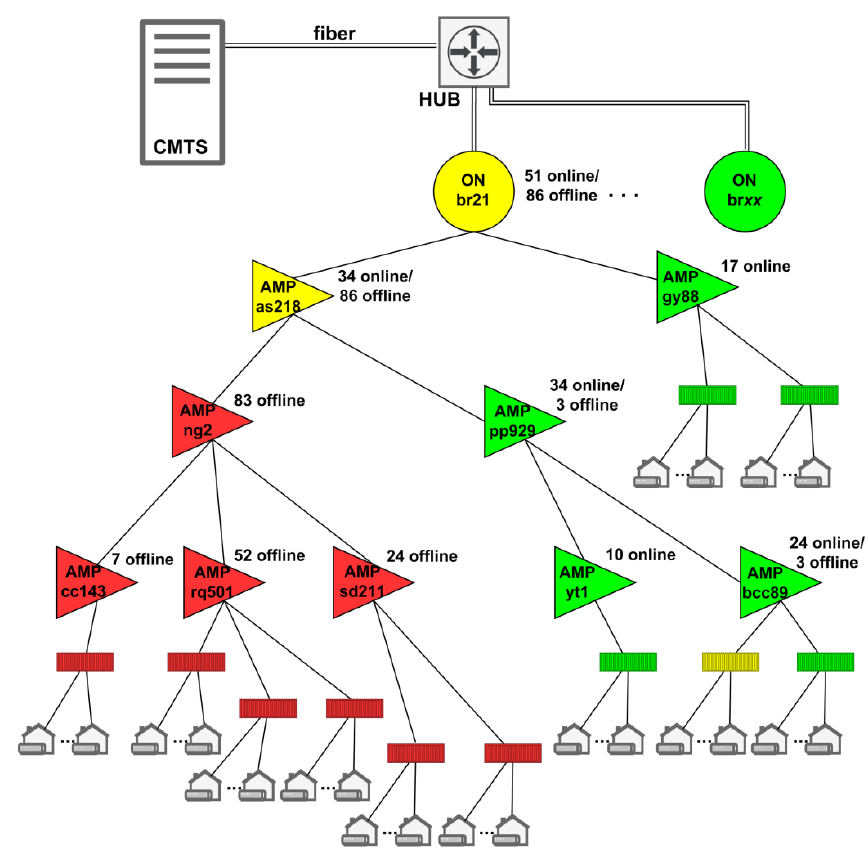
Figure 3. Failure localization example.